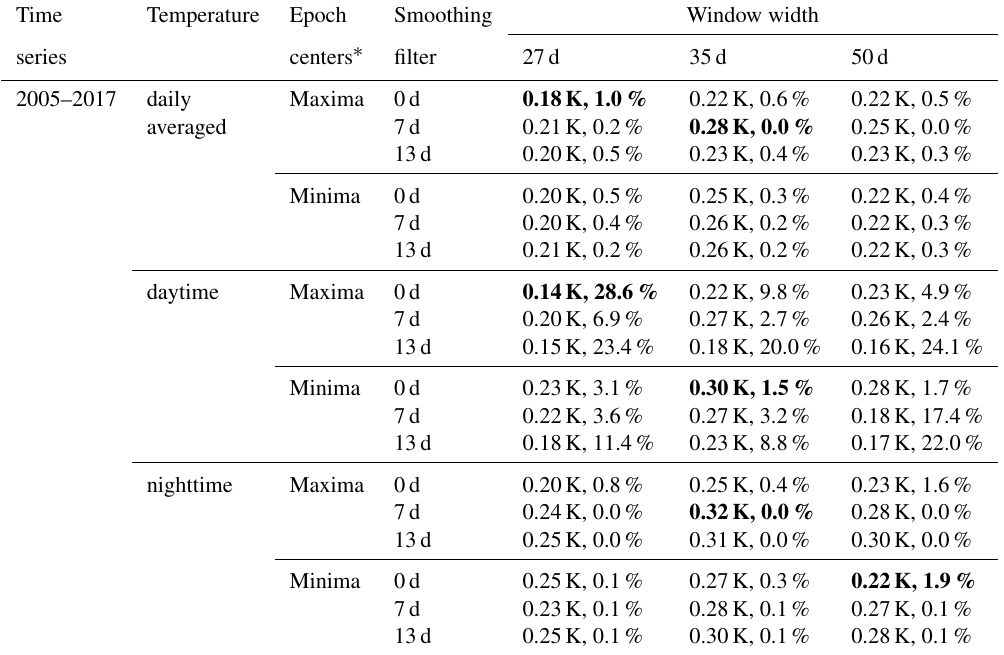
Table 1. Significance testing results for different input parameters used in the analysis. The temperature data at a latitude of 5 ◦ N and altitude of 88km are used here. There are two parameters shown in the table. The first one is absolute amplitude in K of the fitted sinusoidal function. The second one is the fraction (%) of random realizations with amplitudes larger than actual data. The values in bold font correspond to the maximum and minimum of the fraction of random realizations with amplitudes larger than the actual data for the daily averaged, the daytime and the nighttime